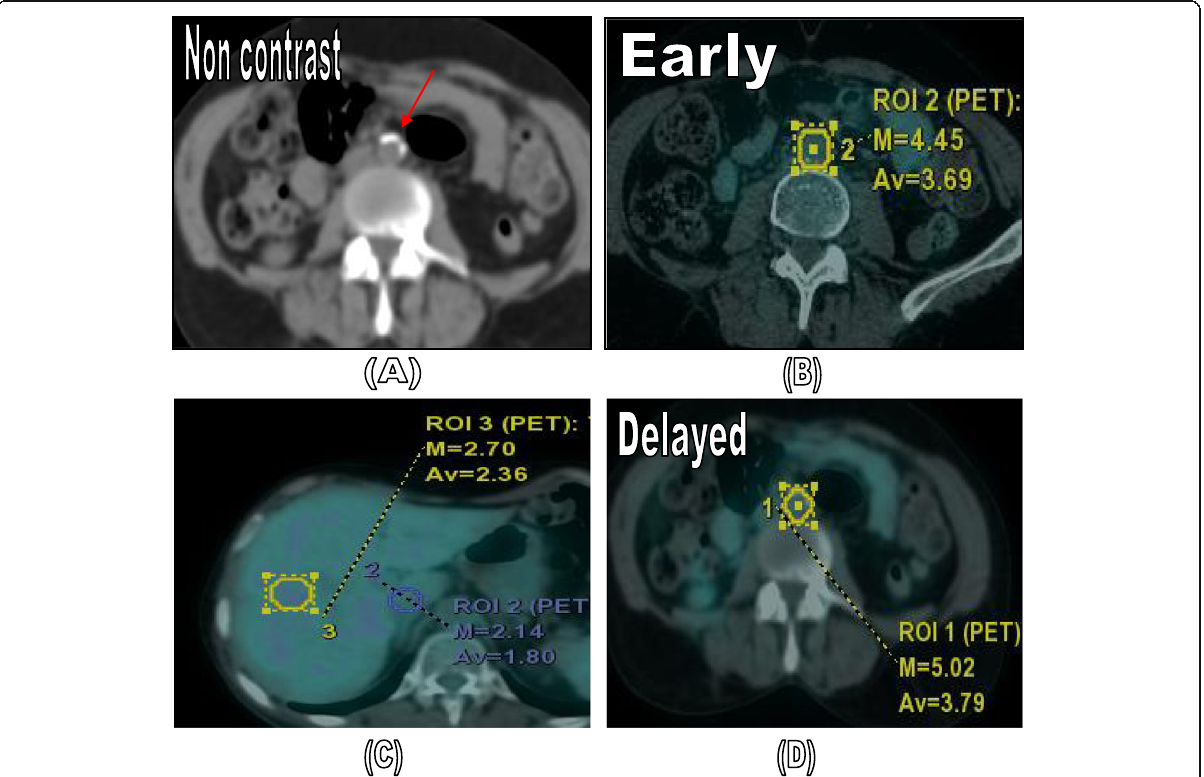
Fig. 2 Male patient 58-year-old, non-smoker, non-diabetic, non-hypertensive. He underwent PET/CT for cancer prostate staging. a Non contrast CT images showed dense calcified atheromatous plaque involving 50% of the abdominal aorta circumference. b Early PET/CT images after 1 h showed measurement of SUVmax at the outer wall of the abdominal aorta. c SUVmax measurements at the blood pool (IVC) and liver. d Delayed images after 3 h showed retention of FDG within the active atheroma with SUVmax higher than the blood pool activity (IVC) and liver denoting grade IV atherosclerotic